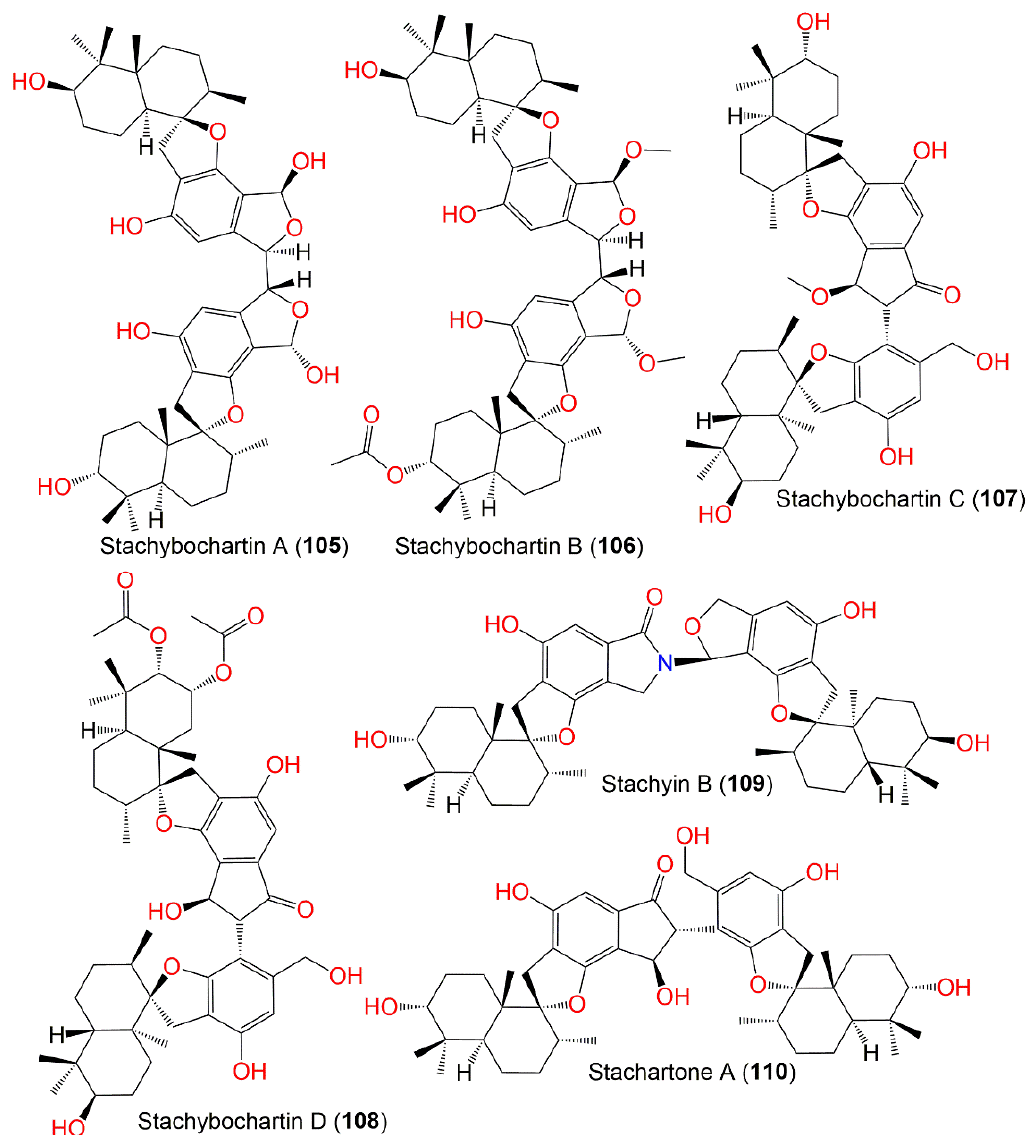
Figure 14. Structures of dimeric phenylspirodrimane derivatives ( 105 – 110 ) reported from S . chartarum .